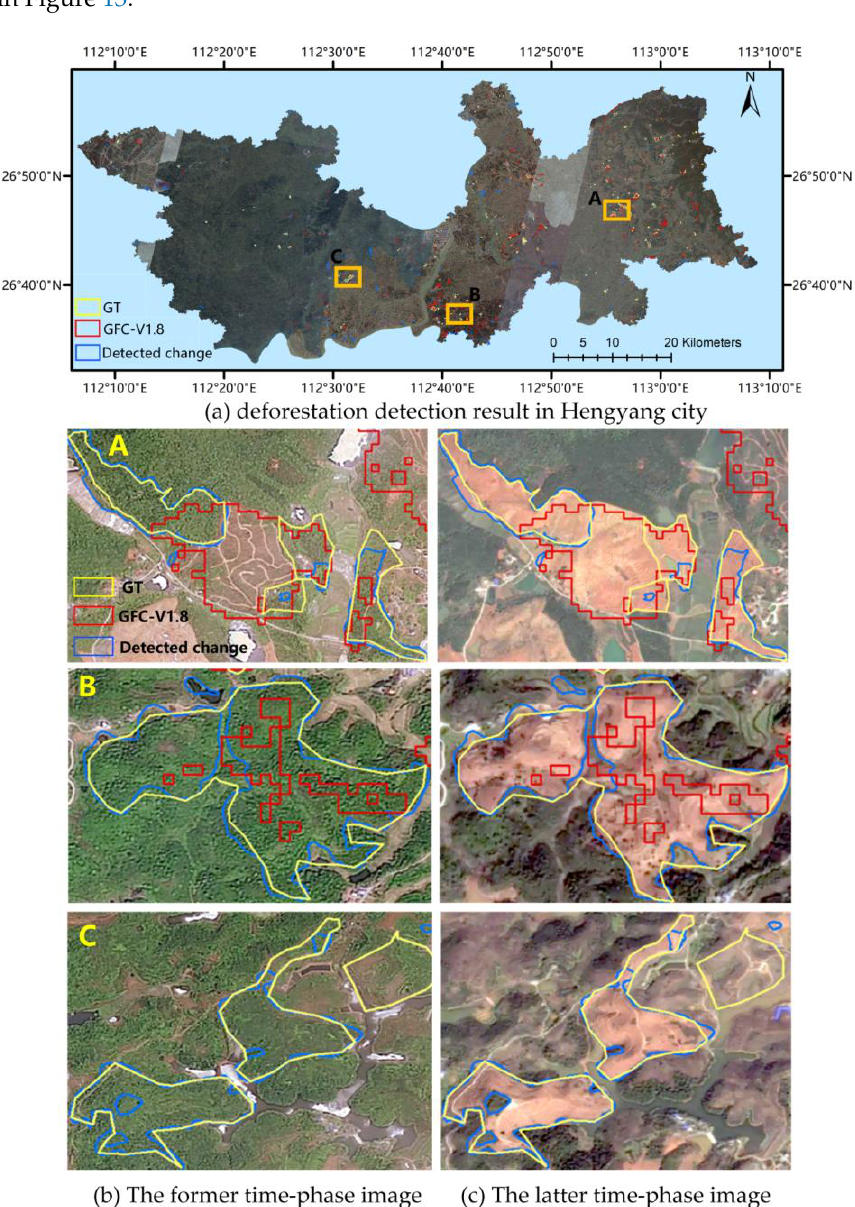
Figure 13. Forest change detection results.